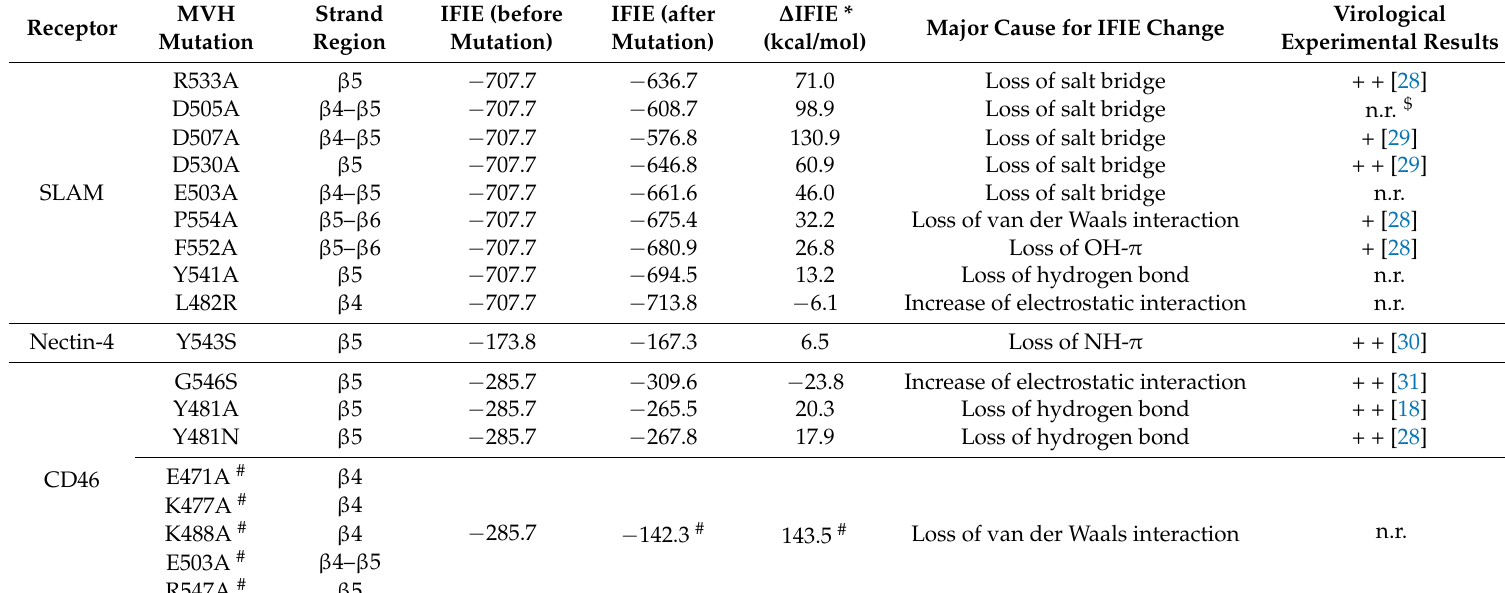
Table 4. Effects of mutations of MVH residues on the binding affinities (IFIE sums in units of kcal/mol) with the three receptors. MVH Strand IFIE Receptor Mutation Region